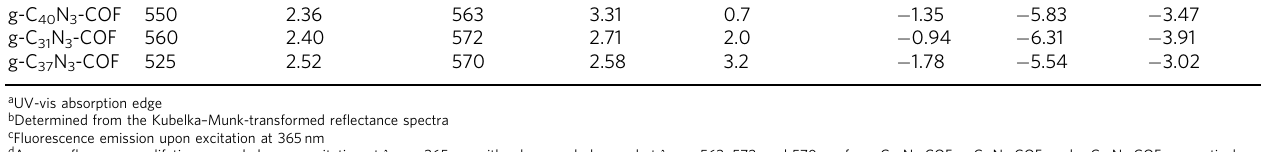
Table 1 Electronic properties of g-C x N y -COFs